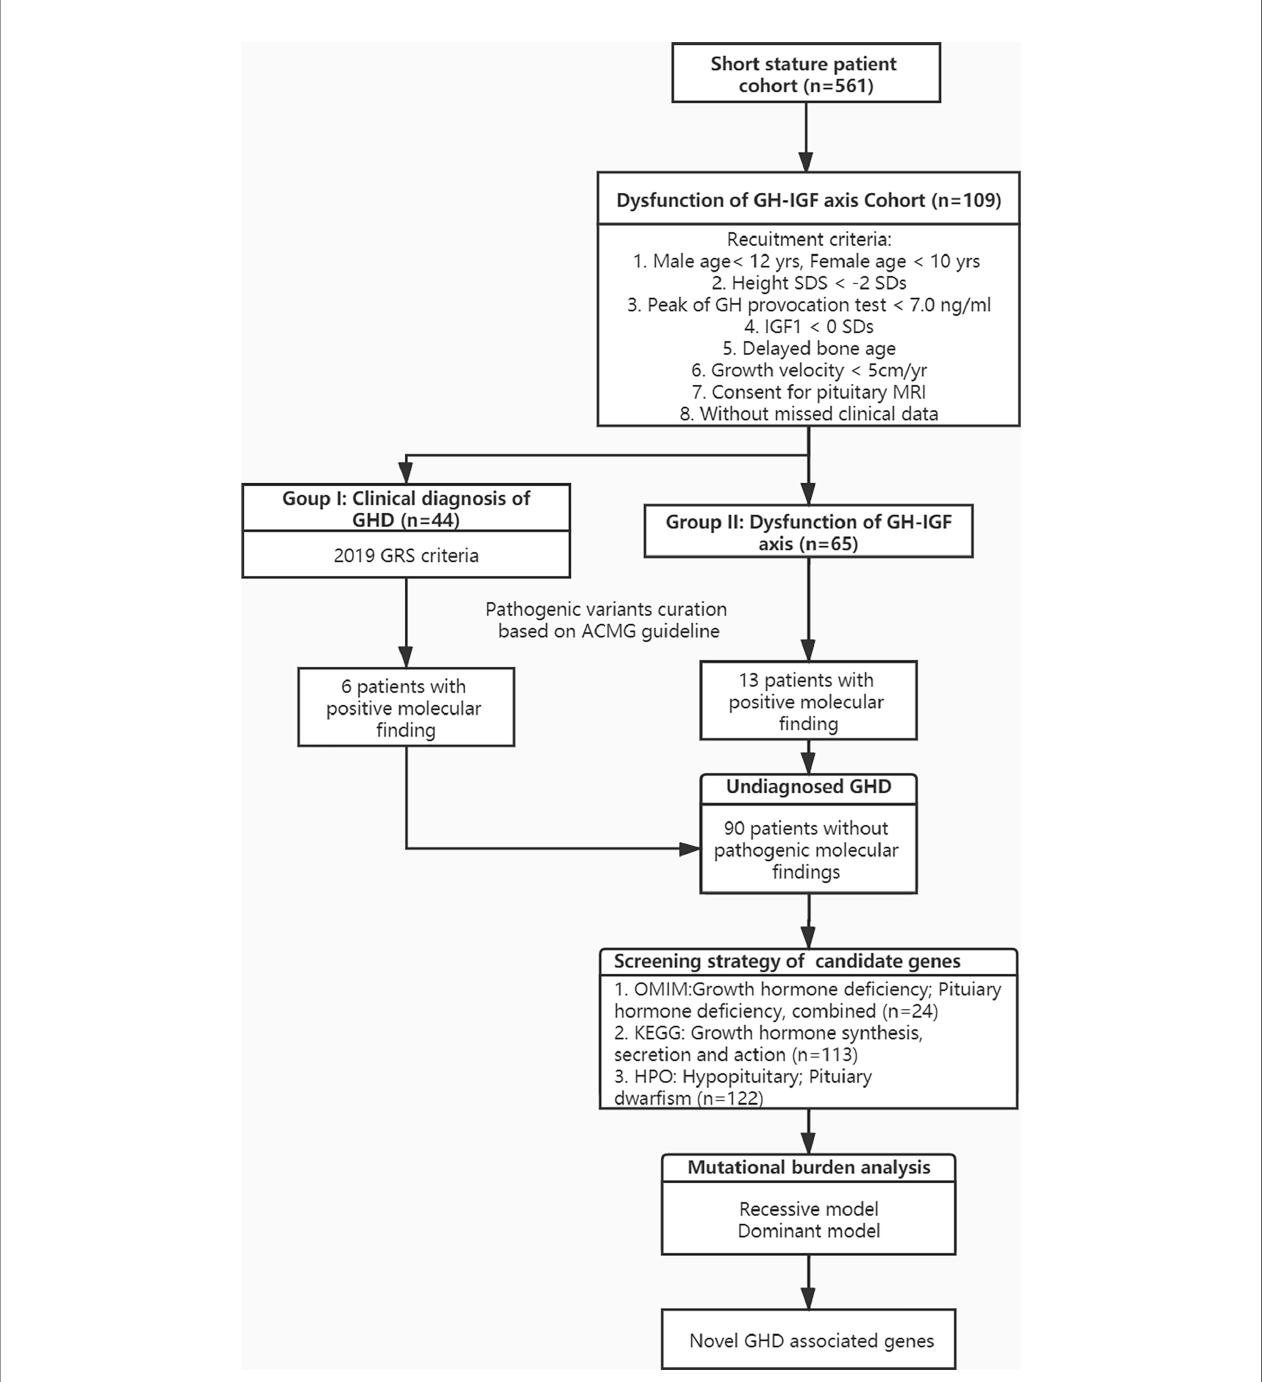
FIGURE 1 | Flowchart of patient enrollment and genetic testing. GHD, growth hormone de fi ciency; GH, growth hormone; IGF, insulin like growth factor 1; SD, standard deviation; OMIM, Online Mendelian Inheritance in Man; KEGG, Kyoto Encyclopedia of Genes and Genomes; HPO, Human Phenotype Ontology; GRS, GH Research